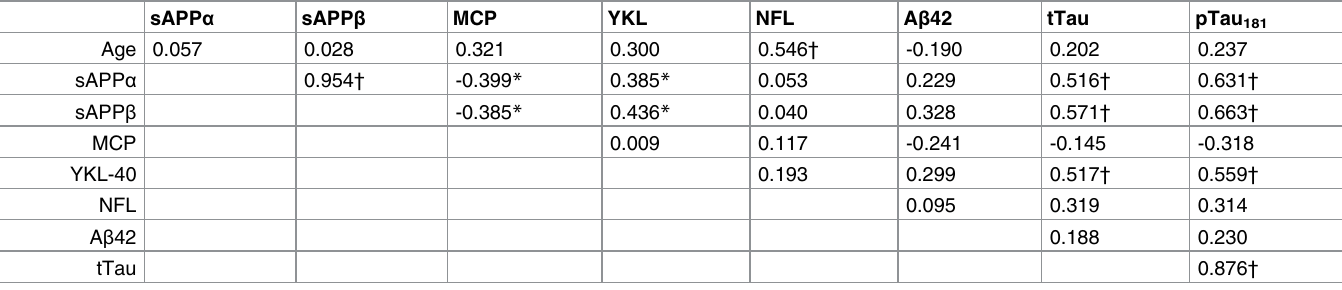
Table 2. Linear Pearson Correlation between biomarkers and age.